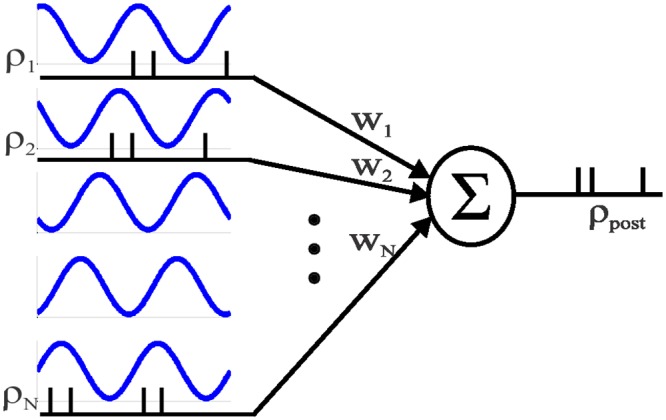
A schematic description of the network architecture showing the pre-synaptic population of oscillating neurons serving as feed-forward input to a single post-synaptic neuron.